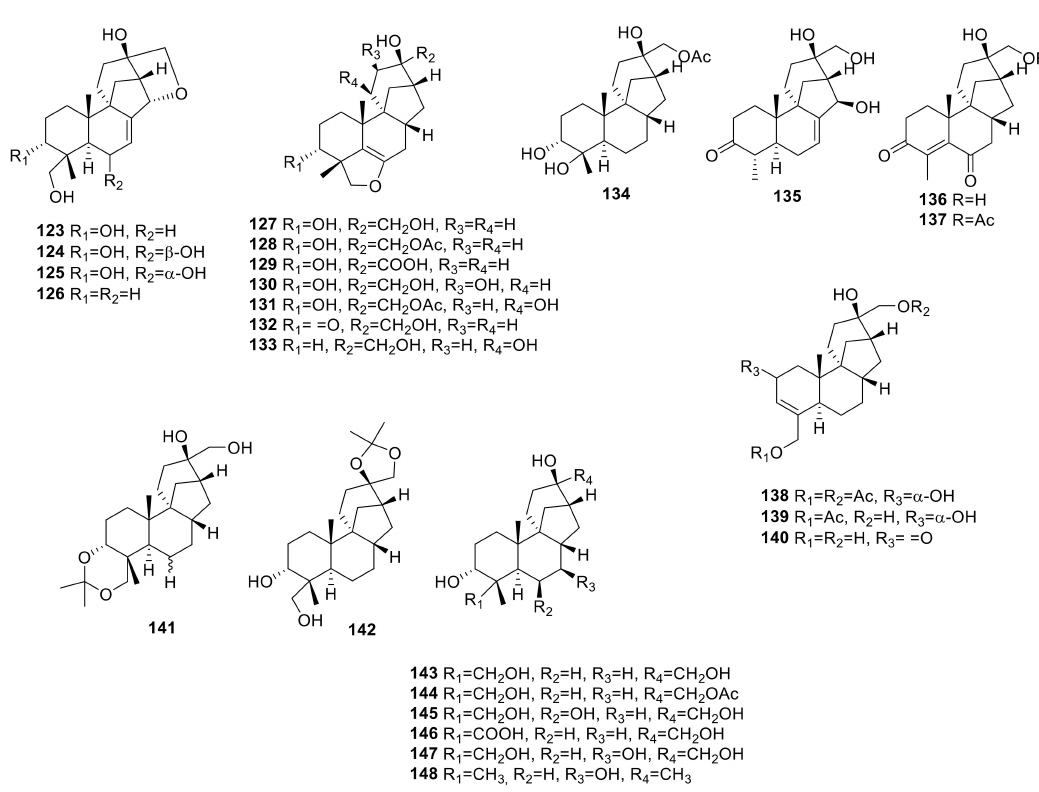
Figure 20. Structure of other diterpenoid derivatives 123 - 148 .